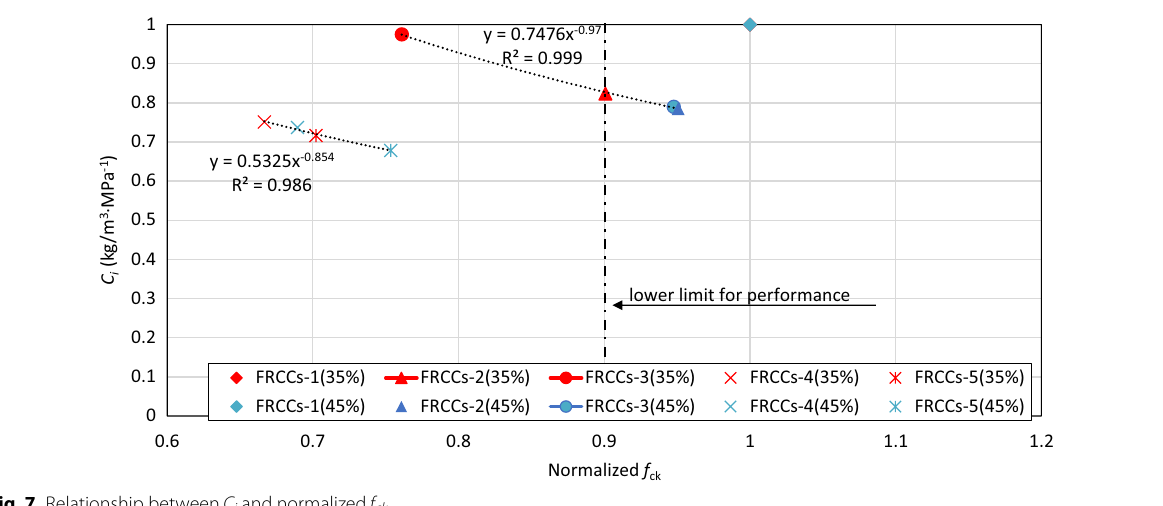
y = 0.7476x -0.97 R² = 0.999